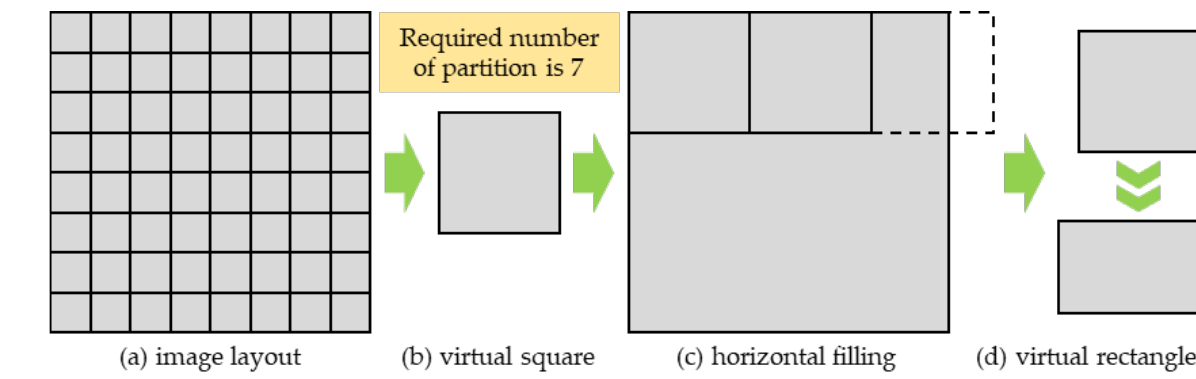
Figure 1. Flowchart for the horizontal filling.